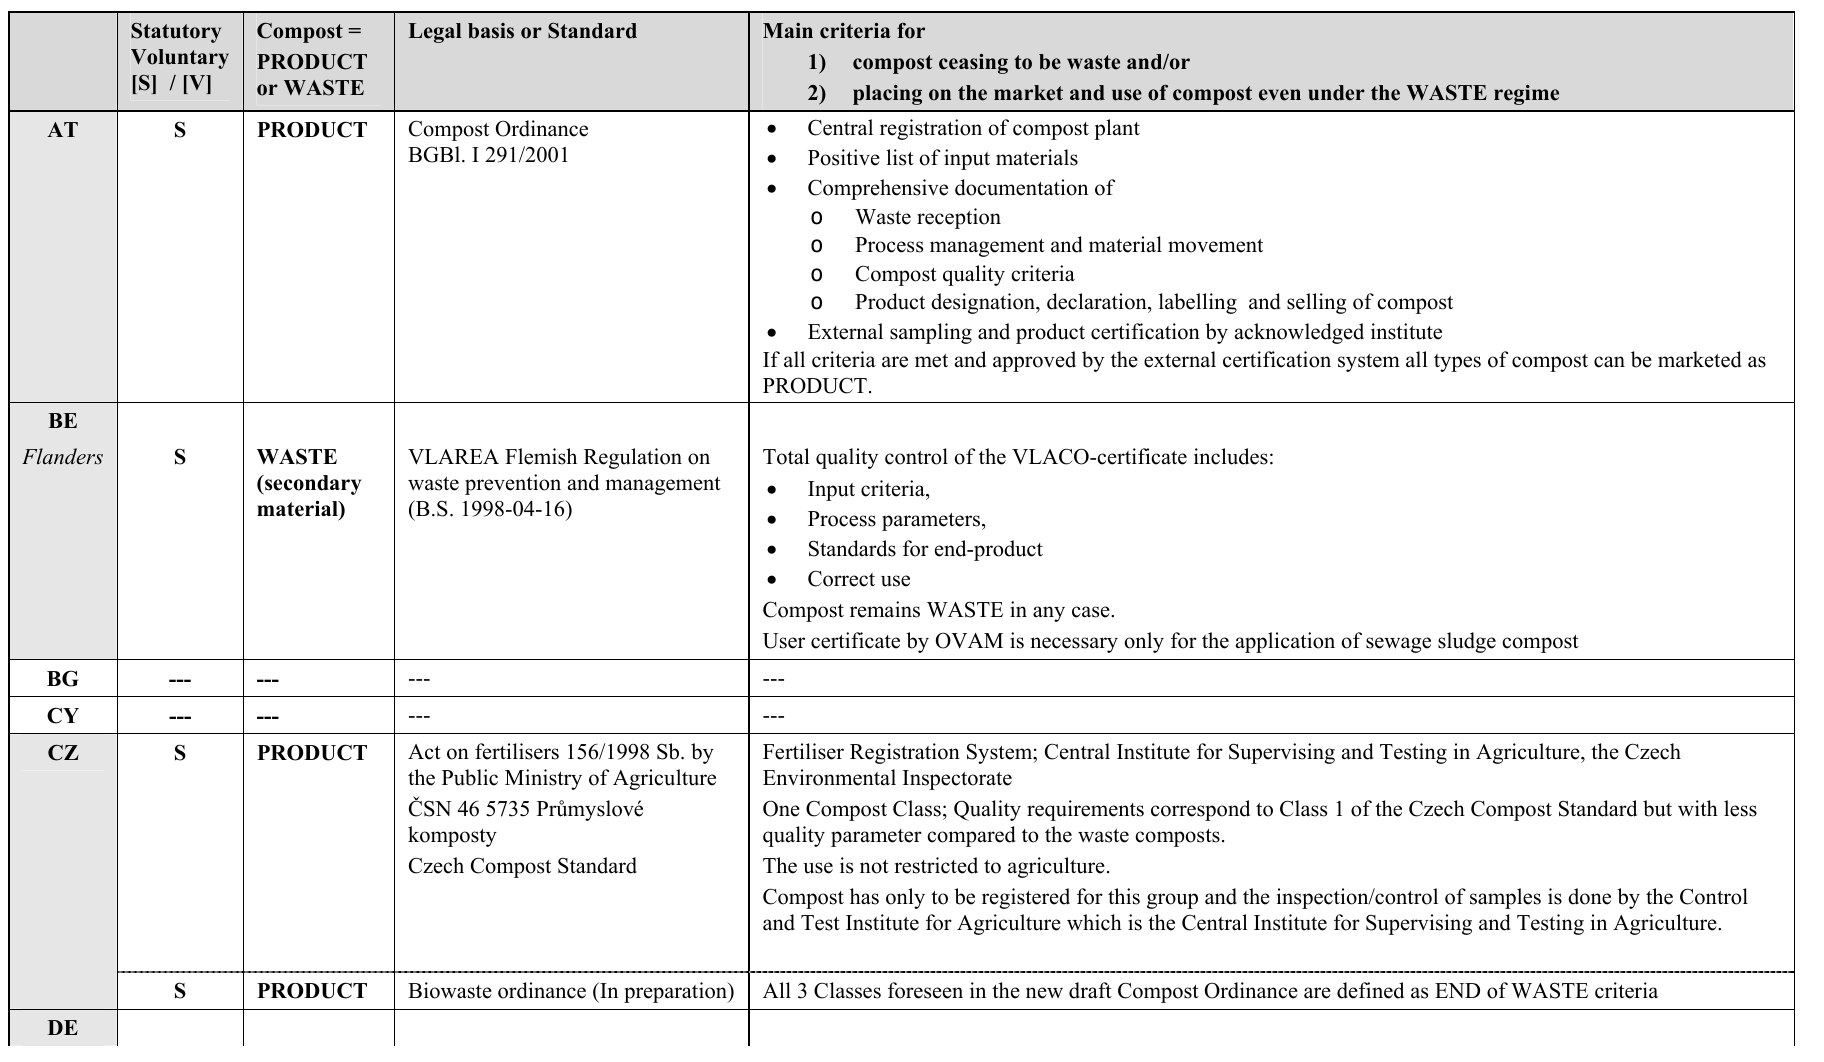
Table 27: Criteria and national regulations which define whether a compost produced from waste may be marketed as product or is still within the waste